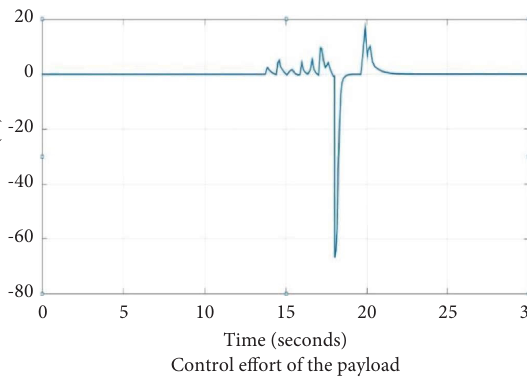
Figure 12: System exerted efort with the third input signal using hybrid controllers.